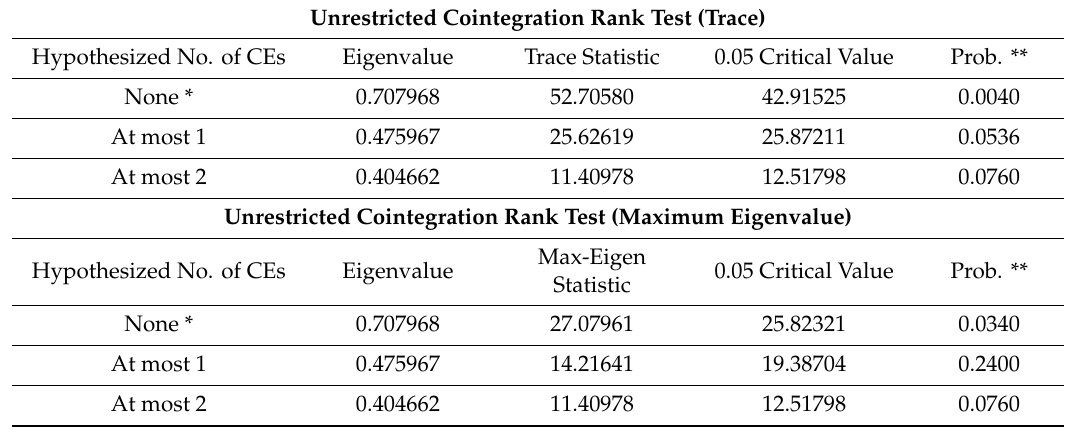
Table 7. Johansen cointegration